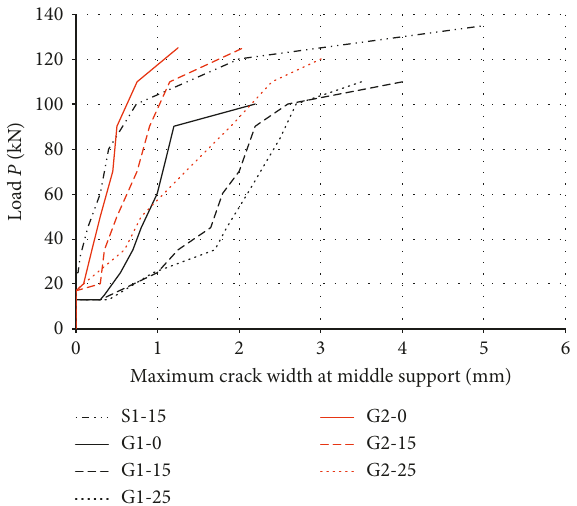
Figure 7: Load-maximum crack width relationship at the middle support for tested